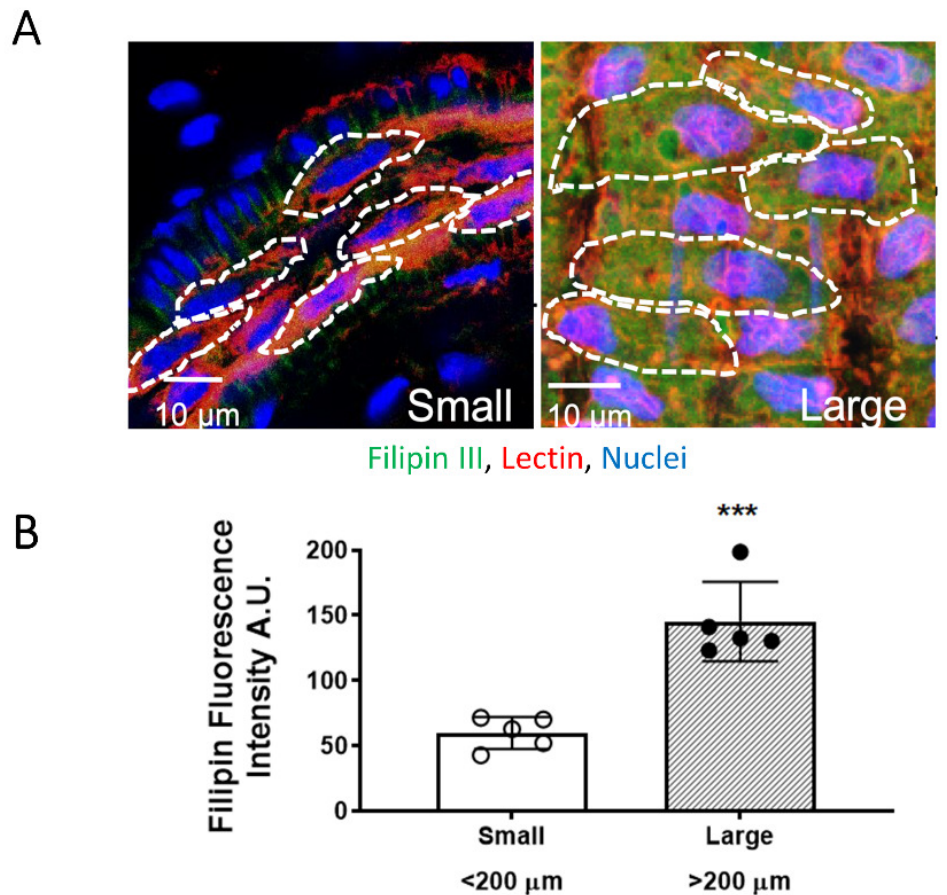
Figure 2. Cholesterol content in large (>200 µ m) and small (<200 µ m) mesenteric arteries. ( A ). Rep- resentative en face images of cholesterol marker, filipin III (green, 20 µ g/mL) and endothelial glycoprotein marker Lectin (red, 20 µ g/mL) acquired at 63x with additional digital zoom of small artery for visualization of cells. Nuclei are labeled with SYTOX (blue). ( B ). Mean ± S.D. *** p = 0.0004, unpaired t test.